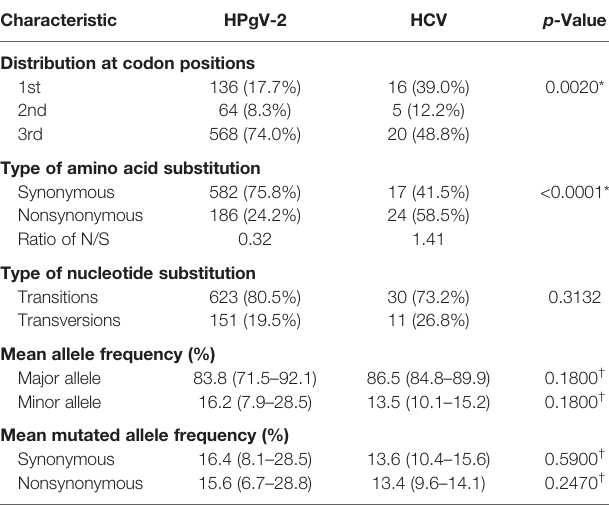
TABLE 3 | Characteristic of intrahost single nucleotide variations in the genome of HPgV-2 and HCV